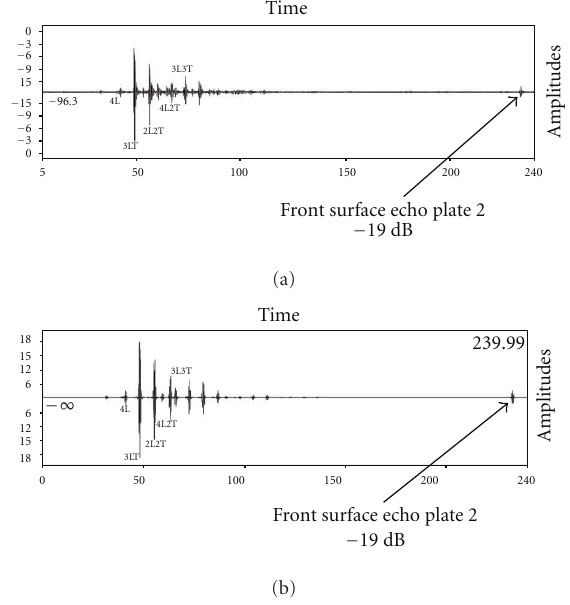
Figure 6: Inspection through screens for a 45 ◦ configuration at 2.25MHz, experimental (a) and simulation